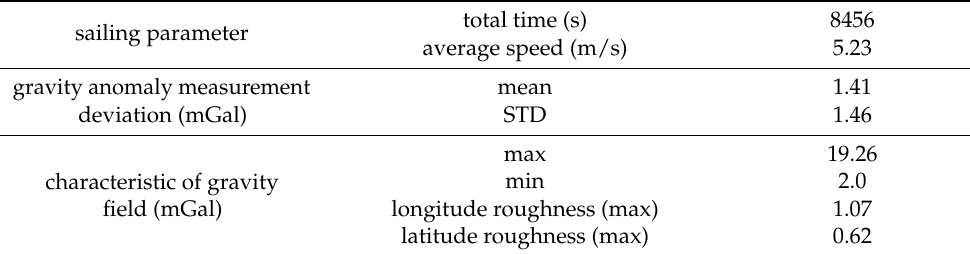
Table 5. Information of the sailing track 3.